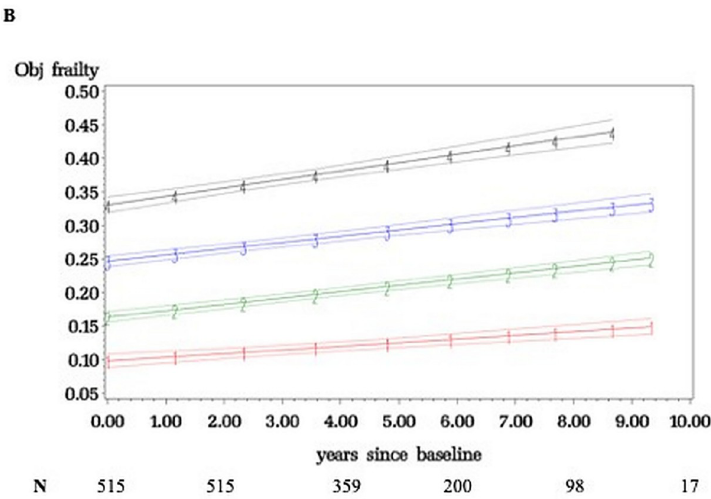
Fig 2. Frailty trajectories with 95% confidence intervals in Einstein Aging Study cohort. Four trajectory classes identified: relatively stable (1), mild frail (2), moderate frail (3) and severely frail (4). The Y-axis depicts the frailty index scores (range 0 to 1) and x-axis follow-up time in